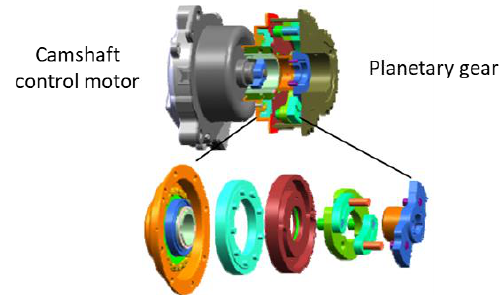
Fig. 4. Elements of the applied variable phase execution system [31] An additional advantage of using electrical variable camshaft phasing control is the relatively small upgrade to the current timing system of the test engine. The scheme of acceleration and deceleration of the timing phases in the applied system is shown in Fig.